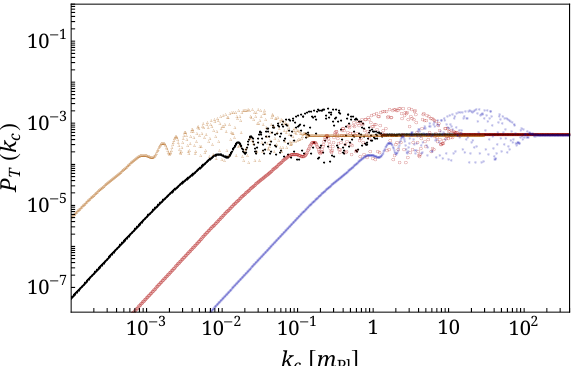
Figure 15. Primordial tensor power spectra obtained from an evolution with a bounce characterized by C = 1, µ = − 600, σ = 2, and B = 0.4, and different values of A . From left to right: A = 0.1 (orange triangles), A = 1 (reference case, black disks), A = 10 (red circles) and A = 100 (blue